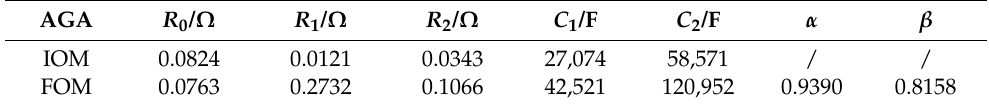
Table 1. Parameter values for FOM and IOM.